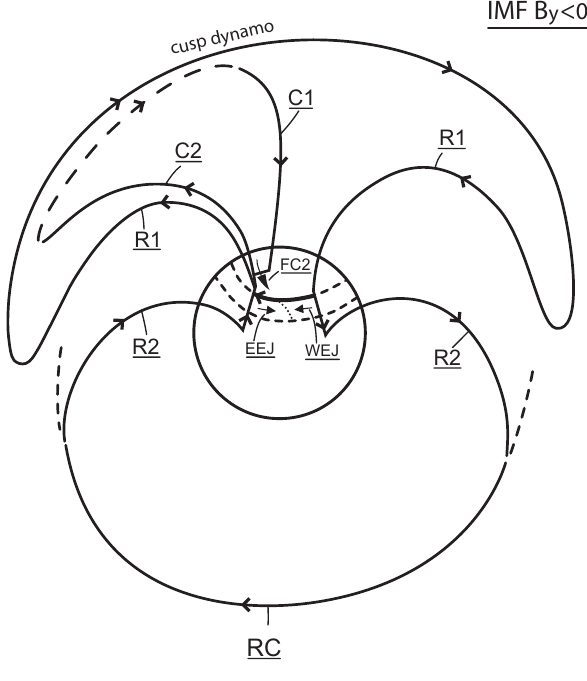
Fig. 12. Schematic illustration of current loops in the magnetosphere-ionosophere system adapted after Tanaka et al. (2010). Birkeland current systems (R1–R2 and C1–C2), magne- tospheric ring current (RC), cusp dynamo current, and ionospheric closure currents have been marked. The FC 2 current loop (cusp dynamo current – C1–C2 Birkeland currents – ionospheric Peder- sen current) is the topic of this paper. The perspective is from the magnetotail towards the Earth (circle). The auroral oval boundaries are marked by the two dashed curved lines. See text for